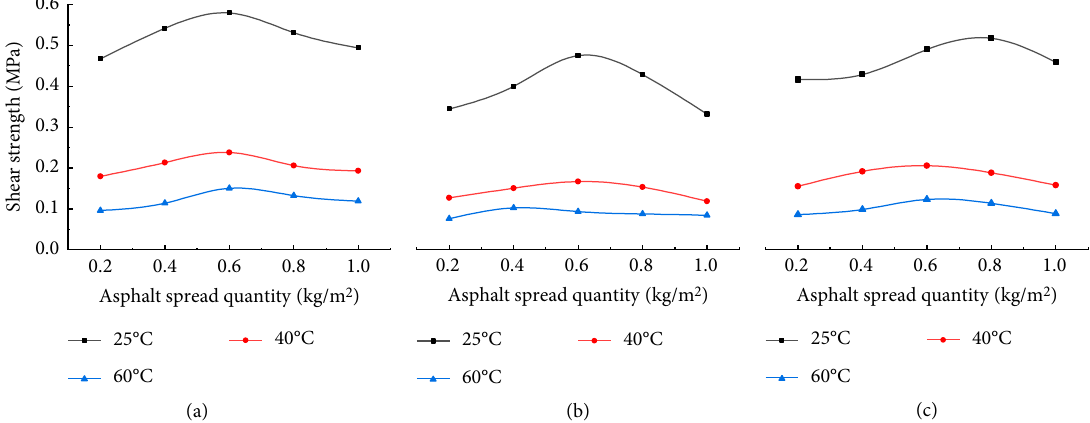
Figure 15: Shear strength of specimens with geogrids interlayer treatment: (a) SBS-modified asphalt, (b) ordinary hot asphalt, (c) SBS-modified emulsified asphalt.